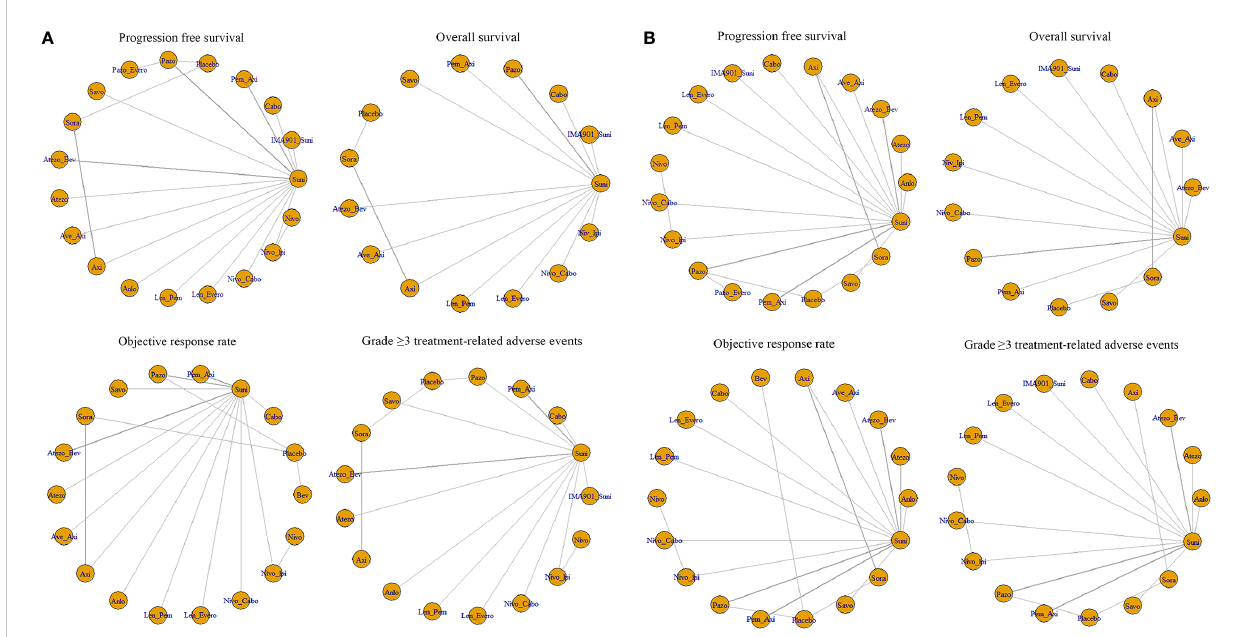
FIGURE 3 (A) Network meta-analysis plots for outcomes of interest in intent-to-treat population and (B) Network meta-regression analysis plots for outcomes of interest in intent-to-treat population. Suni, Sunitinib; Bev, Bevacizumab; Cabo, Cabozantinib; Pazo, Pazopanib; Savo, Savolitinib; Sora, Sorafenib; Axi, Axitinib; Anlo, Anlotinib; Nivo, Nivolumab; Atezo, Atezolizumab; Pem_Axi, Pembrolizumab plus Axitinib; Atezo_Bev, Atezolizumab plus Bevacizumab; Ave_Axi, Avelumab plus Axitinib; Len_Pem, Lenvatinib plus Pembrolizumab; Nivo_Cabo, Nivolumab plus Cabozantinib; Nivo_Ipi, Nivolumab plus lpilimumab; Len_Evero, Lenvatinib plus Everolimus; Pazo_Evero, Pazopanib plus Everolimus; IMA901_Suni, IMA901 plus